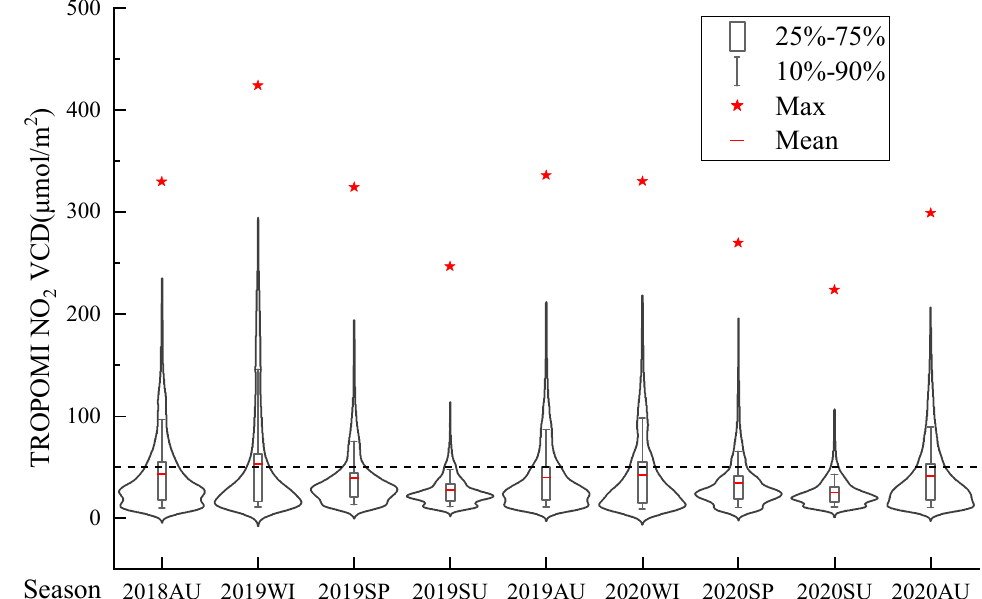
Figure 2. Distribution characteristics of the seasonal average of NO 2 VCD in the YREB from 2019 to 2020 (Note: WI—Winter; SP—Spring; SU—Summer; AU—Autumn, same as below. A violin plot showing the probability density of data distribution is given in this Figure, where the red dashed line and the stars represent the mean and maximum values of the NO 2 VCD in each season in the study area, respectively. The I-shaped box plot corresponds to the 10–90% interval of the NO 2 VCD, and the rectangular box corresponds to the 25–75% interval. The width of the violin plot denotes the frequency of sampling falling into the concentration